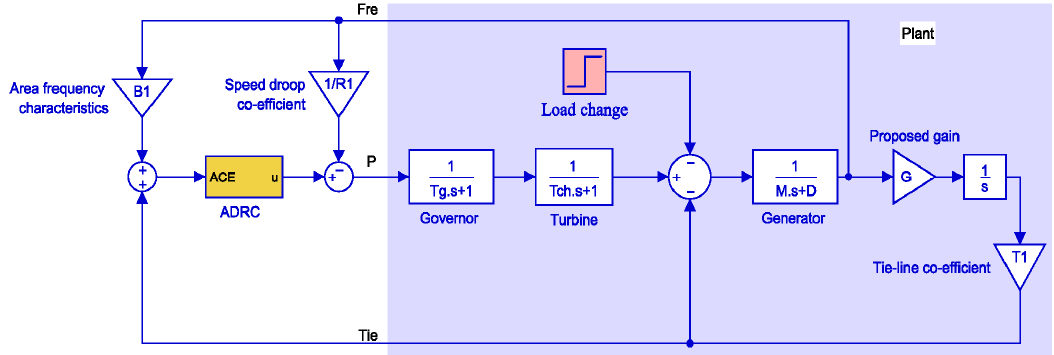
Figure 4. Proposed ADRC-based LFC model for generator H -constant effect.